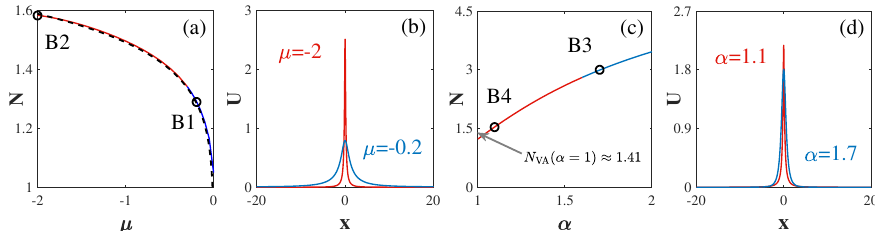
Figure 3. ( a ) Dependence N ( µ ) and ( b ) profiles of solitons labeled B1 and B2 in ( a ) (corresponding to µ = − 0.2 and − 2, respectively), as produced by numerical solution of Equation (8) in the free space ( V = 0), for a fixed value of the Lévy index, α = 1.1, and nonlinearity coefficient, g = 1. ( c ) Dependence N ( α ) and ( d ) profiles of solitons labeled B3 and B4 in ( c ) (corresponding to α = 1.7 and 1.1, respectively) for a fixed propagation constant − µ = 1.5 and g = 1. Blue and red segments in panels ( a , c ) denote subfamilies of stable and unstable solitons, respectively. The black dashed line in ( a ) represents the analytical scaling relation (20). The value marked by the arrow is the µ -independent one (27), predicted by the VA for the degenerate family of the quasi-Townes solitons . Its numerically found counterpart is given by Equation (30). The stability and evolution of the solitons labeled by B1–B4 are displayed in Figure 4. The plots are borrowed from Reference [47] (unpublished).